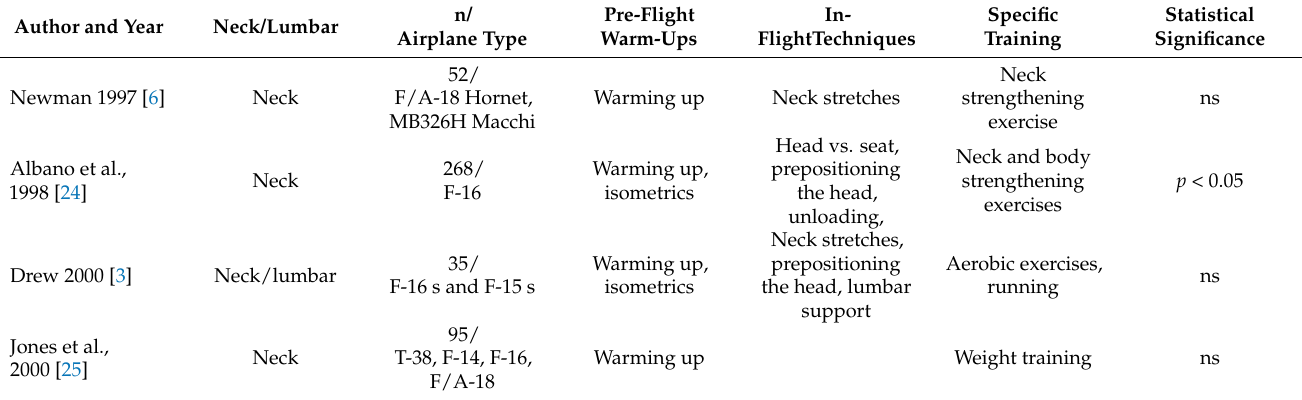
Table 3. Characteristics of the included studies. Study shows first author and year of